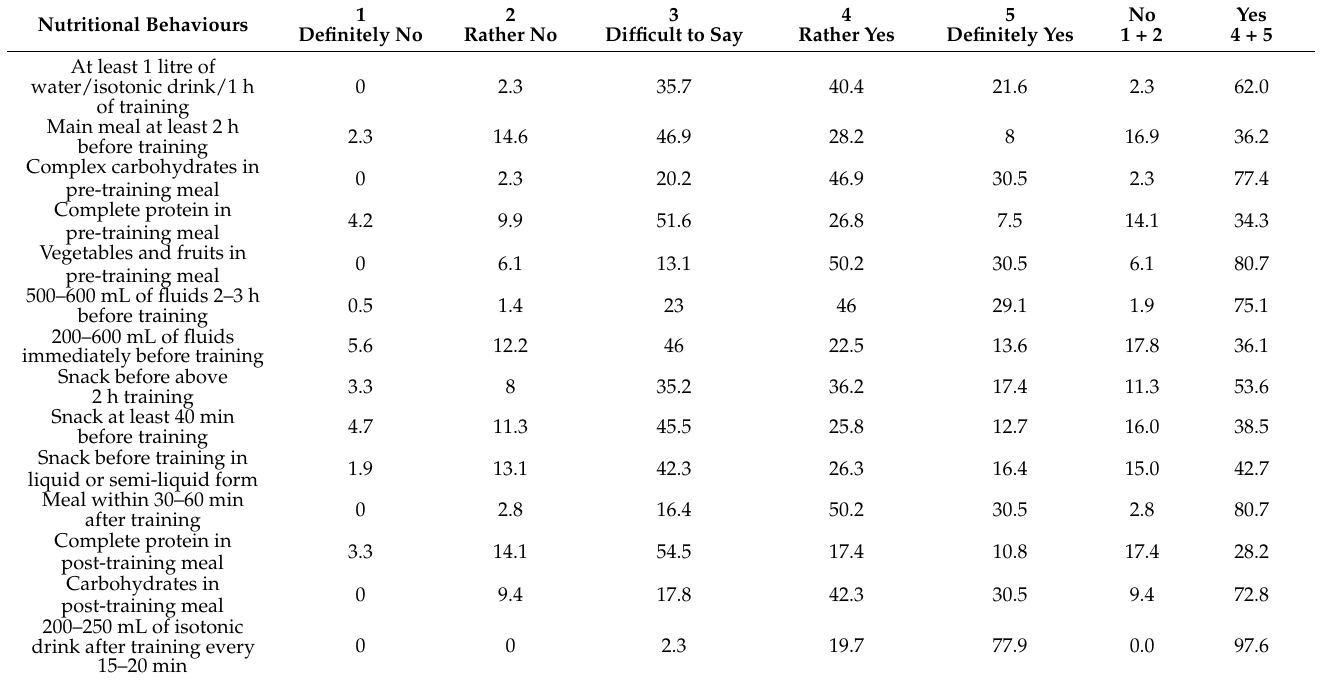
Table 1. Implementing recommendations of peri-exercise nutrition among athletes training team sports (percentage of indications).